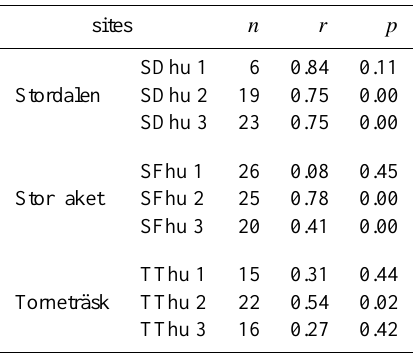
Table 2. Correlation between δ 13 C and C / N ratio with correla- tion coefficient and error probability at hummocks in the three palsa